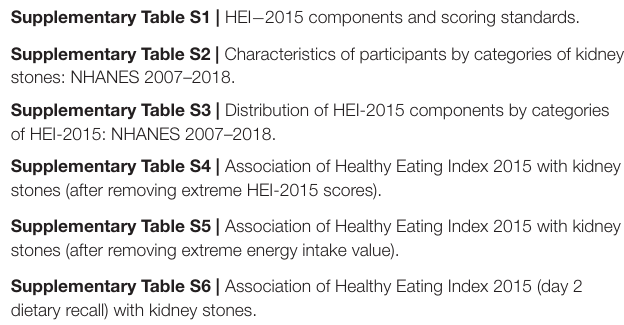
Supplementary Table S1 | HEI − 2015 components and scoring